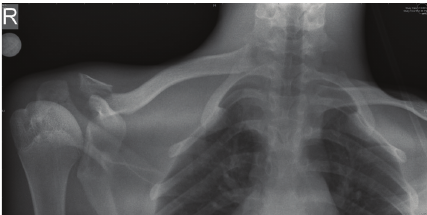
Figure 1: Radiograph at first presentation showing fracture lateral end of right clavicle and sternoclavicular dislocation—the floating clavicle.